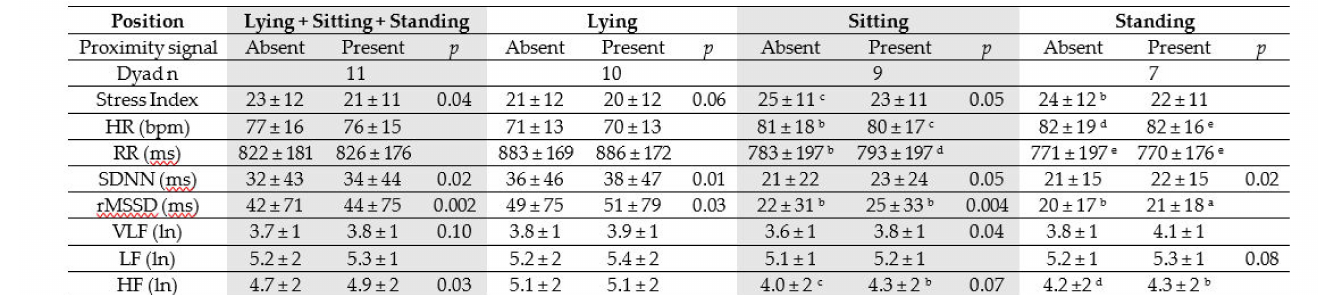
Table 6. Minute-by minute human HR and HRV data (mean ± SD) by position and